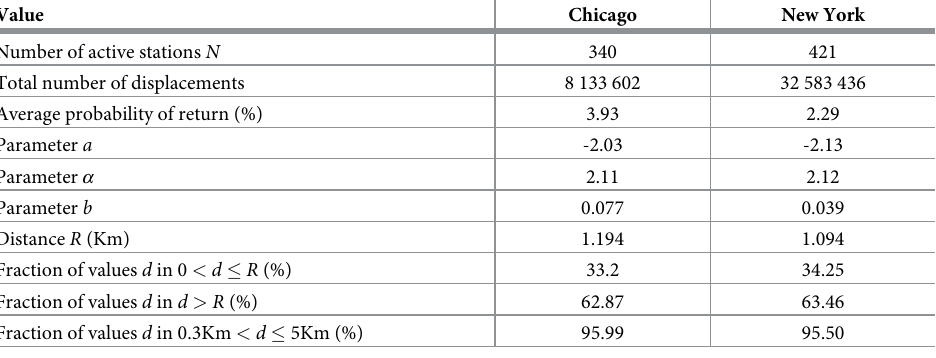
Table 1. Characteristics of the spatial dynamics in bike-sharing systems. The number N denotes the active stations considered in the definition of the OD matrix. The total number of displacements is presented as well as the fraction of trips with distances d classified in different intervals. The values a , b and α for the best fit are obtained by the formalism developed in the Methods section. In addition, the value R = 10 b (Km) defines a local neighborhood around each sta- tion. Beyond this characteristic distance, the displacements are well described by long-range transitions with a Le´vy- like dynamics that follows the relation w ð OD Þ / d (cid:0) a i ! j ij